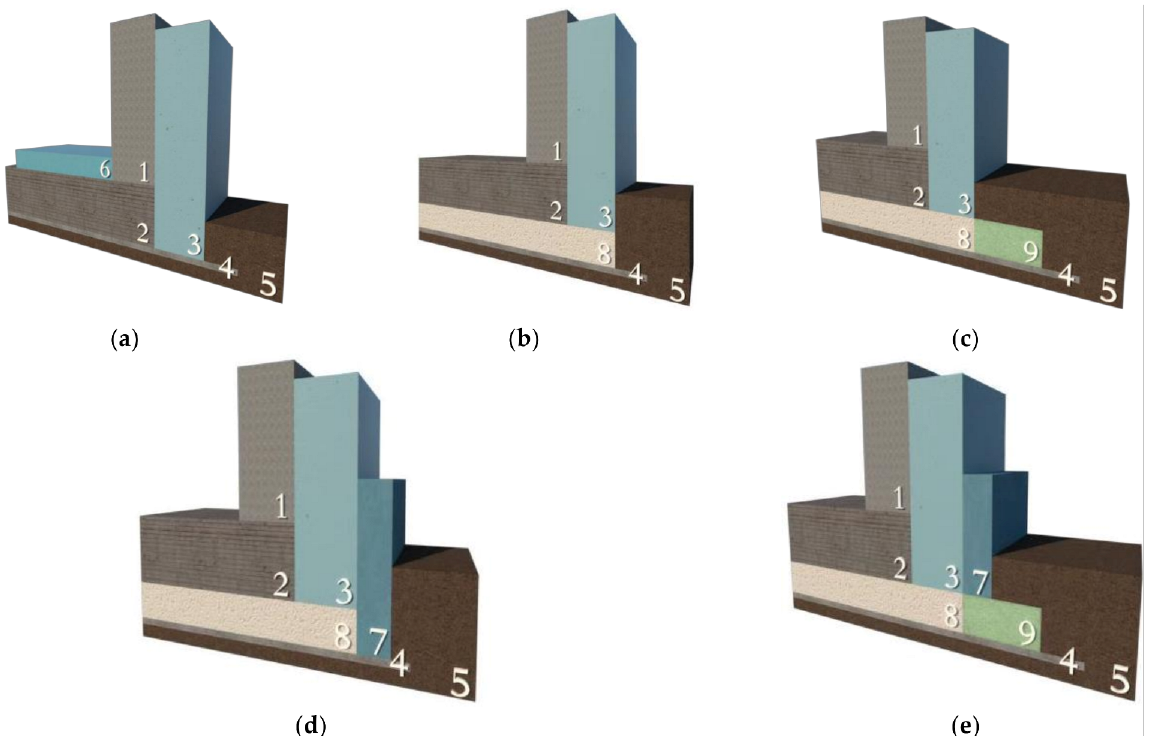
Figure 5. Model construction for each working condition. ( a ) Group A model construction. ( b ) Group B model construction. ( c ) Group C model construction. ( d ) Groups D and E models. ( e ) Group F model construction. (1) Hollow brick walls. (2) Reinforced concrete raft slab foundations. (3) The 200 mm thick EPS board wall external insulation. (4) Concrete bedding. (5) Soil. (6) Ground insulation within 2m of the perimeter of the external wall. (7) EPS VIRL. (8) XPS GFIL. (9) XPS